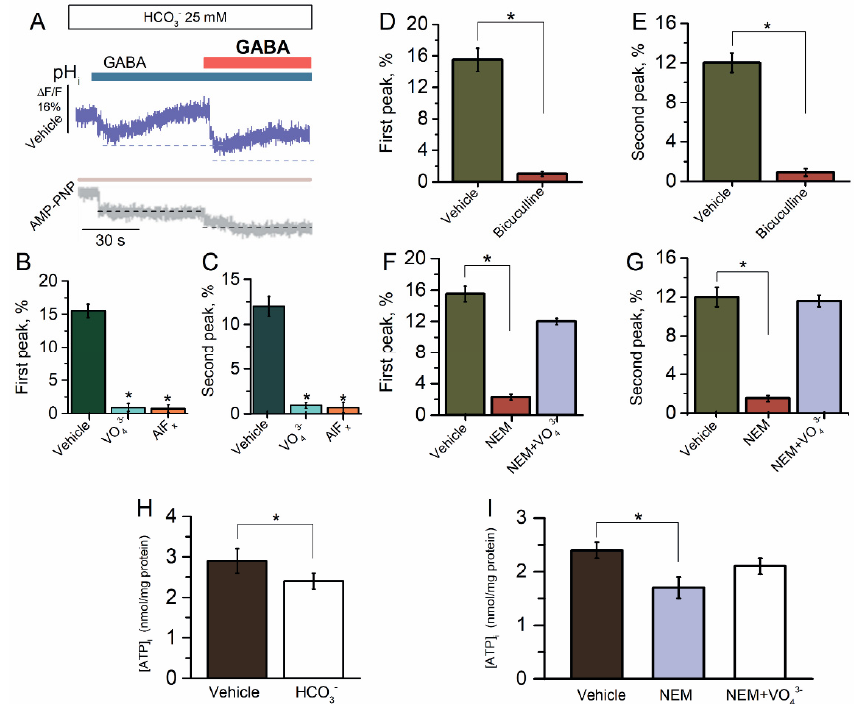
Figure 3. Reapplication of GABA did not reveal the desensitization of GABA A R-mediated HCO 3 − outflux. ( A – C ) Representative images of BCECF fluorescence changes in SNs recorded in response to first application of GABA (100 μ M) and reapplication of GABA (100 μ M) in the presence of HCO 3 − (25 mM) in an experimental medium, without or in the presence of VO 43 − (20 μ M), AlF x (20 μ M), or AMP-PNP (2 mM). ( D ) Bar graph of percentage in BCECF peak fluorescence changes in response to first application of GABA (100 µ M), without or in the presence of bicuculline (50 µ M) (one-way ANOVA, Tukey’s test: F (9,6) = 130.4, p = 0.000075, n = 6). ( E ) Bar graph of percentage